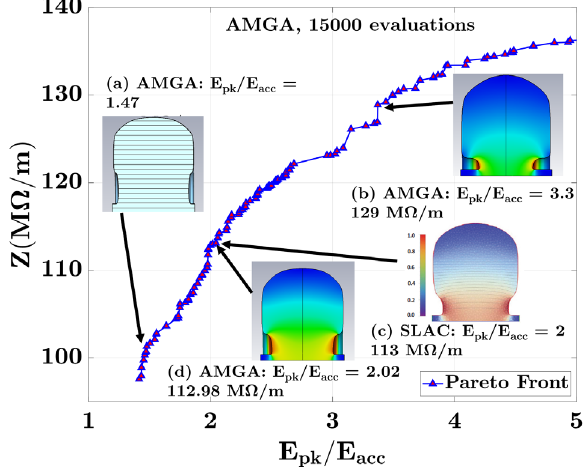
=E FIG. 9. Z vs E Pareto front for an S-band SW cavity pk acc optimization. SLAC image reproduced from Ref.